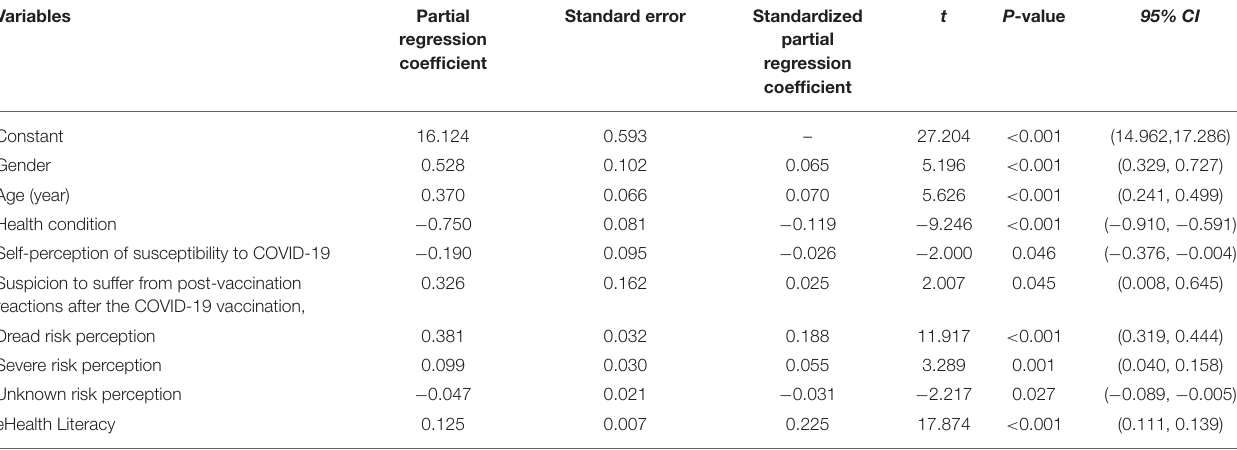
TABLE 3 | Multivariate linear regression analysis on the protective behaviors following the vaccination for Chinese college students ( N = 5,641).